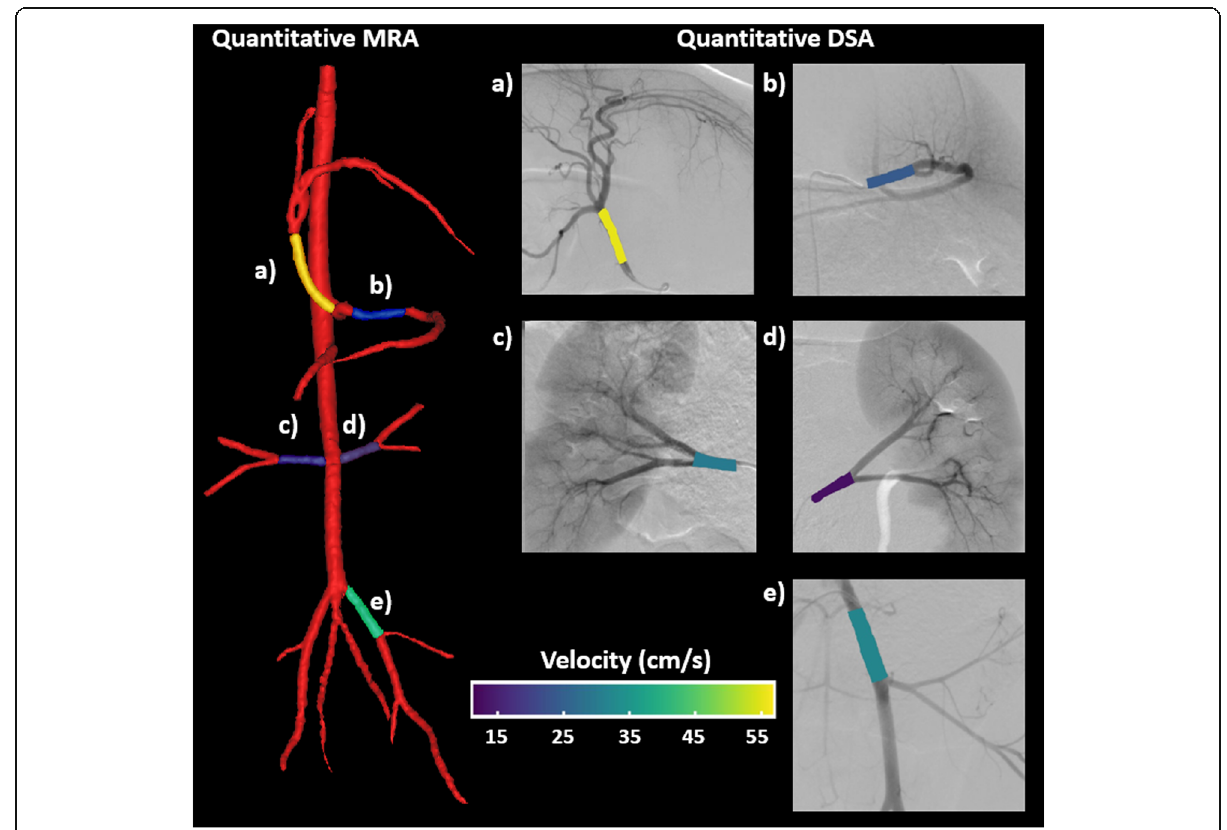
Fig. 6 Quantitative angiographic images for both the 4D Flow MRI and qDSA methods from Swine 1. The magnetic resonance angiogram (MRA) 3D reconstruction was manually segmented and average velocities were calculated for the associated DSA vessels. The distribution of velocities was similar between both imaging